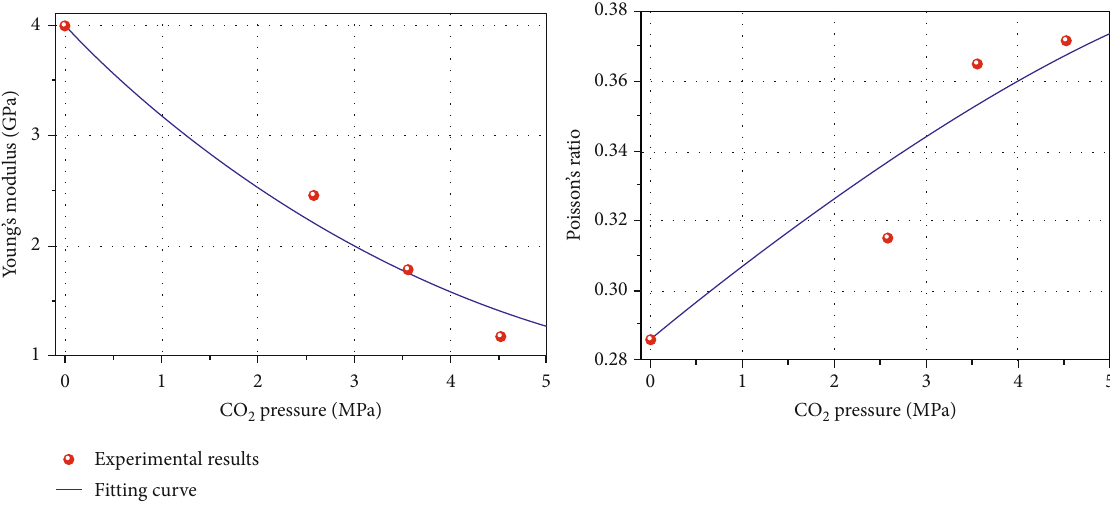
Figure 4: Experimental data of Young ’ s modulus and Poisson ’ s ratio at di ff erent CO